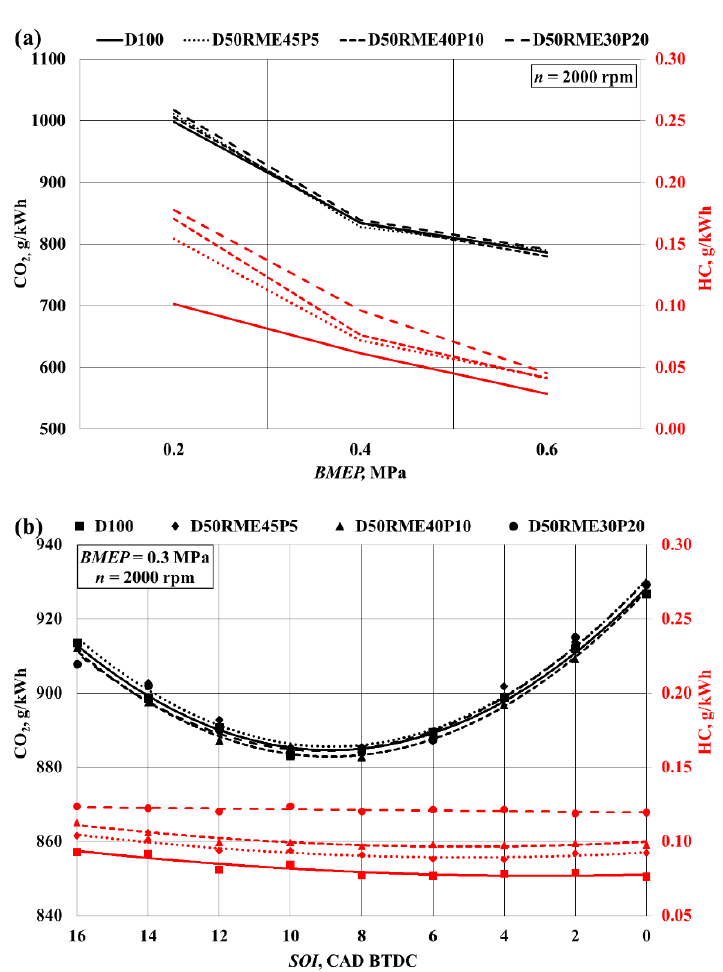
Figure 4. Dependence of carbon dioxide emissions and hydrocarbons on different: ( a ) loads; ( b ) injection timing.